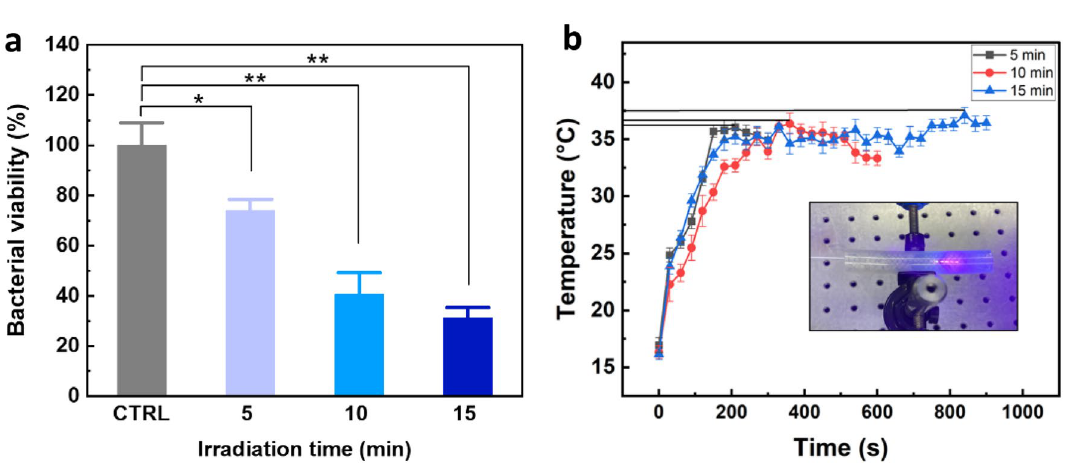
Figure 3. Inhibition of bacterial biofilm after 405 nm laser irradiation: (a) bacterial viability after exposure of 405 nm laser light at various irradiation times (CTRL = control; * p < 0.05 and ** p < 0.001 vs. CTRL; N = 5) and (b) temperature development during laser irradiation on urethral stent